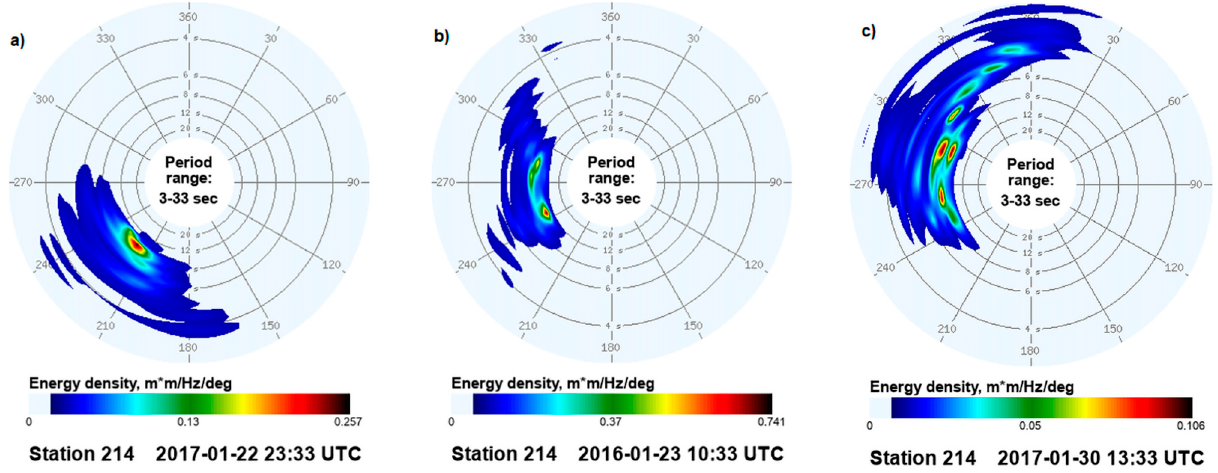
Figure 10. The polar spectrum of three of the 32 highest rogue waves between 2015 and 2019, showing the energy density direction of the wave spectrum as measured by the buoy at the entrance of Tampa Bay. Example of ( a ) unimodal sea, ( b ) bimodal sea and ( c ) “mixed” sea. Source: CDIP portal, modified by author.